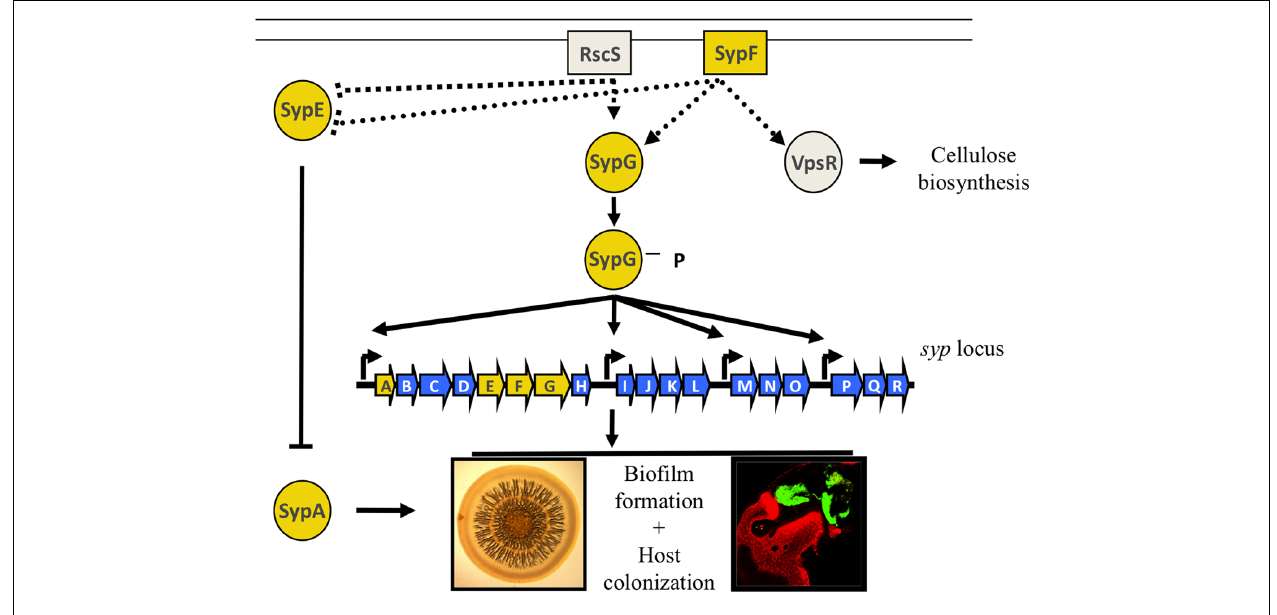
syp transcription to control the phosphorylation state of the small STAS domain protein, SypA. SypF is also predicted to control the activity of a RR VpsR putatively involved in cellulose biosynthesis. Biofilms can be assessed in vitro as a wrinkled colony on an agar plate, or in vivo as a bacterial aggregate that forms on the surface of the light organ. Adapted from (Visick,